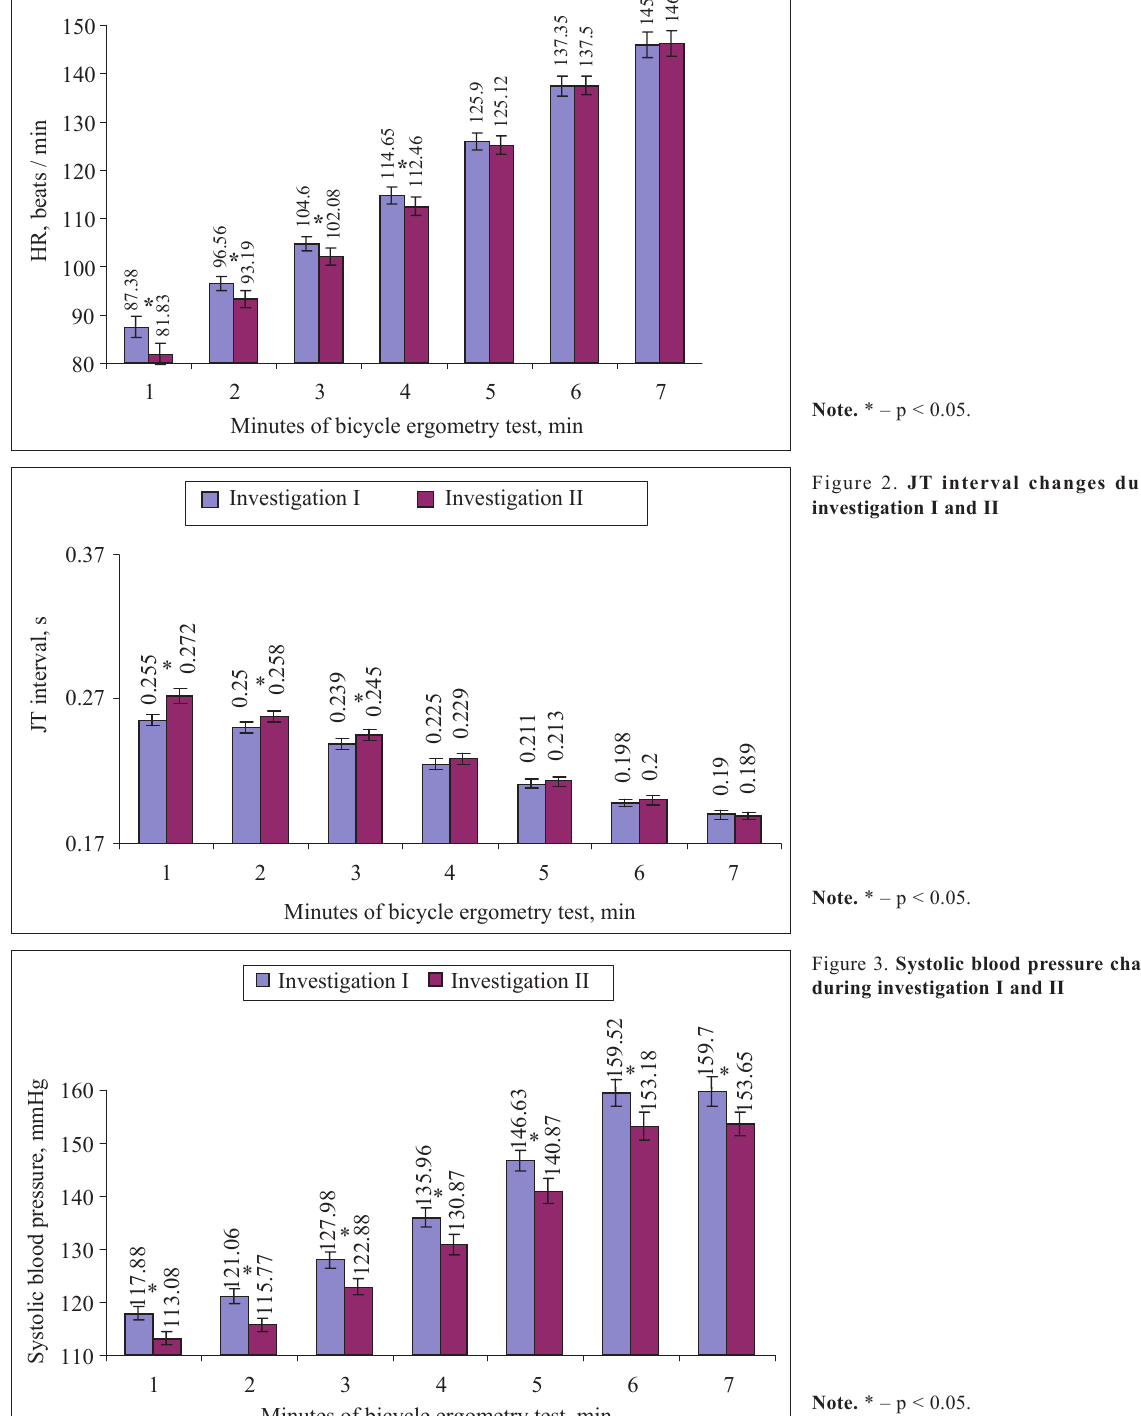
Figure 1. HR changes during investigation I and II